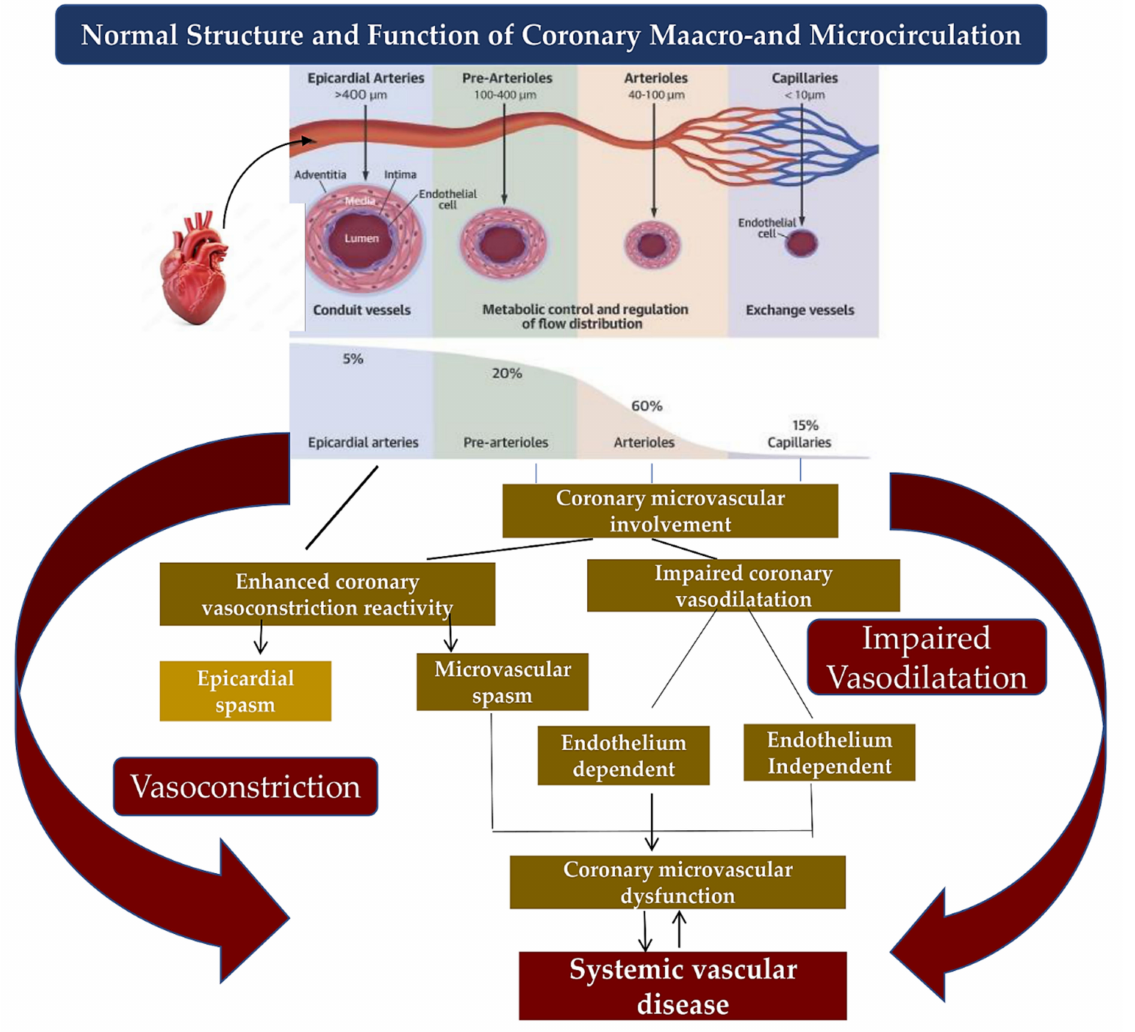
Figure 3. Mechanisms of coronary macrovascular and microvascular dysfunctions. Normal struc- ture and function of coronary macro- and microcirculation is composed by epicardial arteries, pre- arterioles, arterioles, and capillaries. Epicardial spasm typically occurs in the epicardial arteries. On the contrary, coronary microvascular circulation can be subject to impaired coronary vasodilatation due to endothelial and non-endothelium-dependent factors and to microvascular spasm disorder. These phenomena lead to coronary microvascular dysfunction which supports a systemic vascular disease due to vasoconstriction or impaired